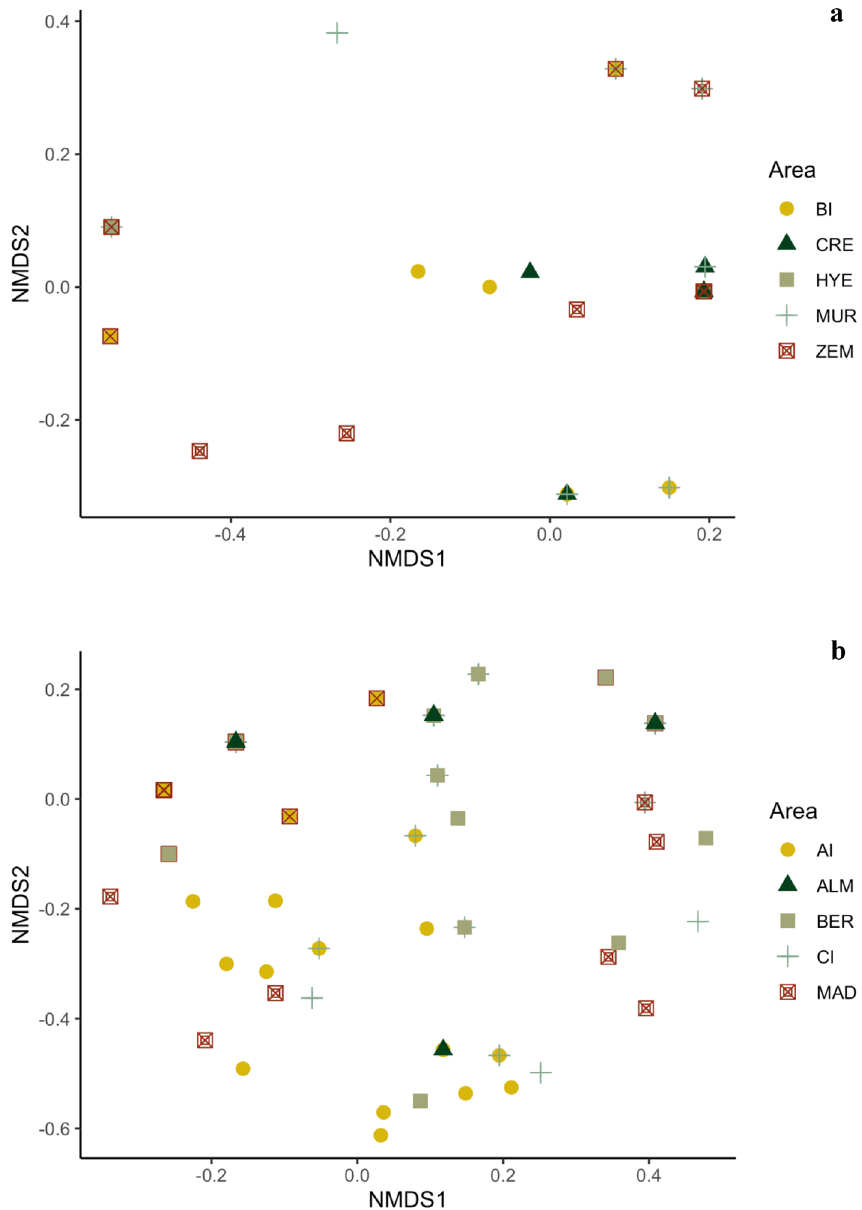
Figure 5. Non-metric multidimensional scaling ordination plot based on Jaccard similarities (data non- transformed, stress = 0.100) for mite infracommunities of ( a ) Scopoli´s shearwaters and ( b ) Cory’s shearwaters across their corresponding sampling colonies/areas. No clear separation of mite infracommunities between colonies was observed for both host species. Abbreviations of the geographical sampling sites/areas are: